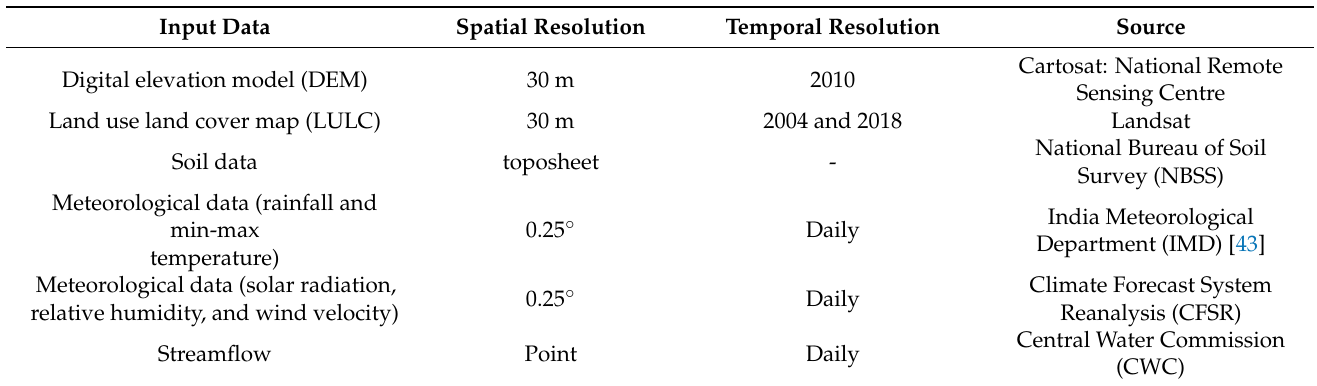
Table 2. Details of the input data used for running the SWAT